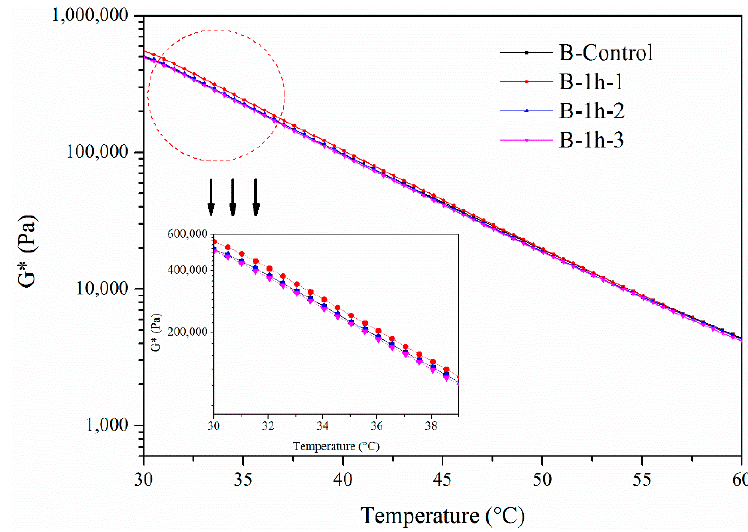
Figure 4. Complex modulus of B aged by UV radiation for 1 h.